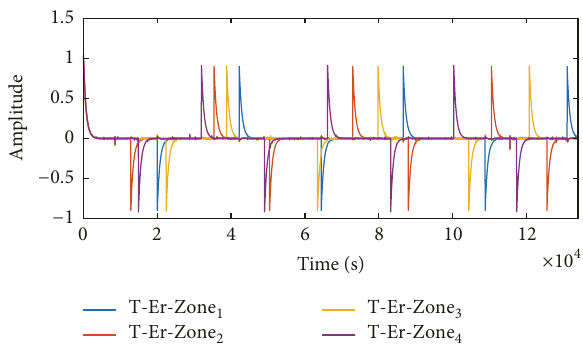
Figure 20: Controller action (steady state error) of temperature responses for each zone